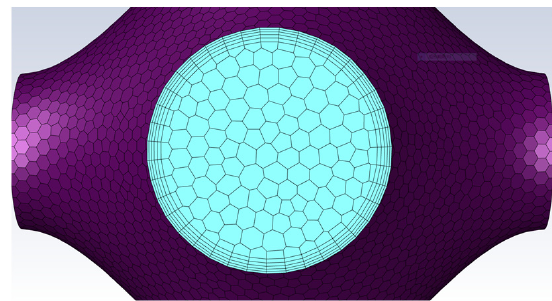
Figure 3. Boundary layer along the wall.